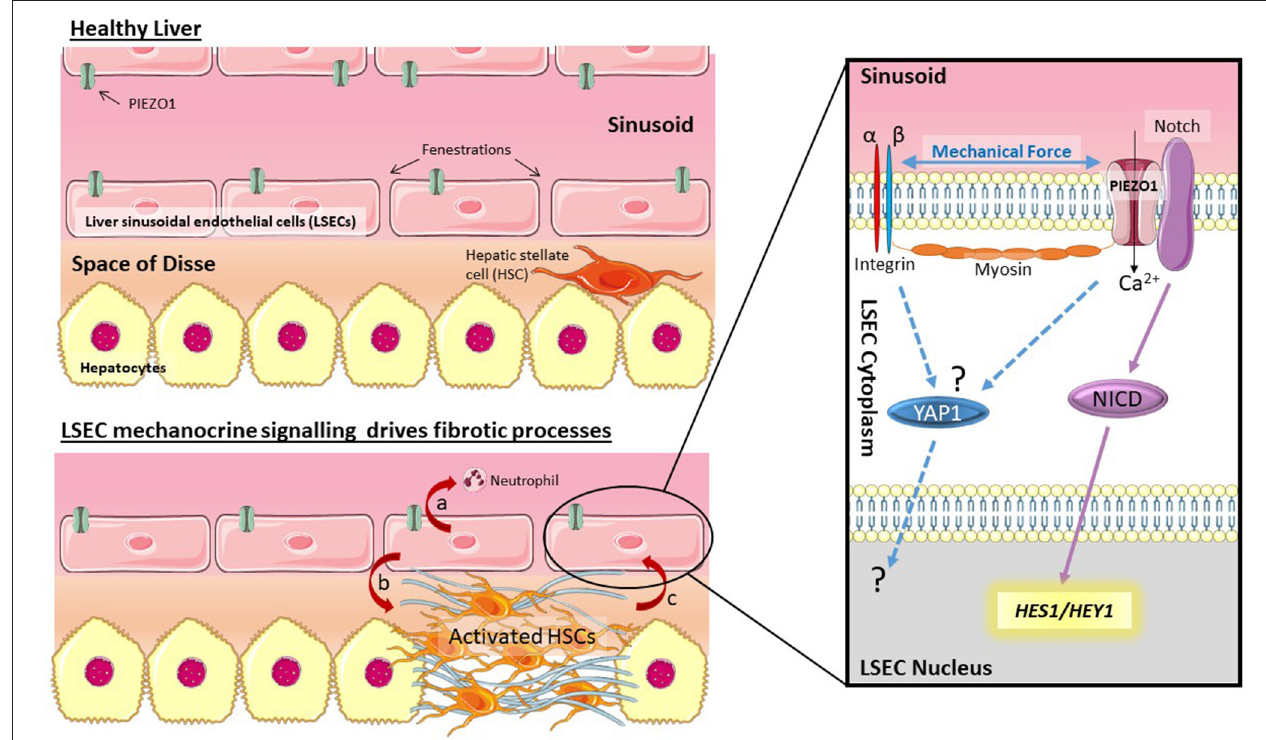
FIGURE 1 | Mechano-sensing by LSECs drives fibrotic processes. LSECs can respond to changes in shear stress and pressure in the sinusoid through activation of PIEZO channels. Data by Hilscher et al. ( 4) suggests this is triggered by integrins and myosin filaments. PIEZO channel activation drives cleavage of Notch to release NICD, and transcription of Notch pathway genes HES1 and HEY1 . Activation of this mechanism results in chemokine secretion (CXCL1) which recruits neutrophils (a). Signaling by LSECs is also known to trigger HSC activation (b) which leads to stiffening of the ECM, potentially driving activation of other mechano-sensitive pathways (c) such as